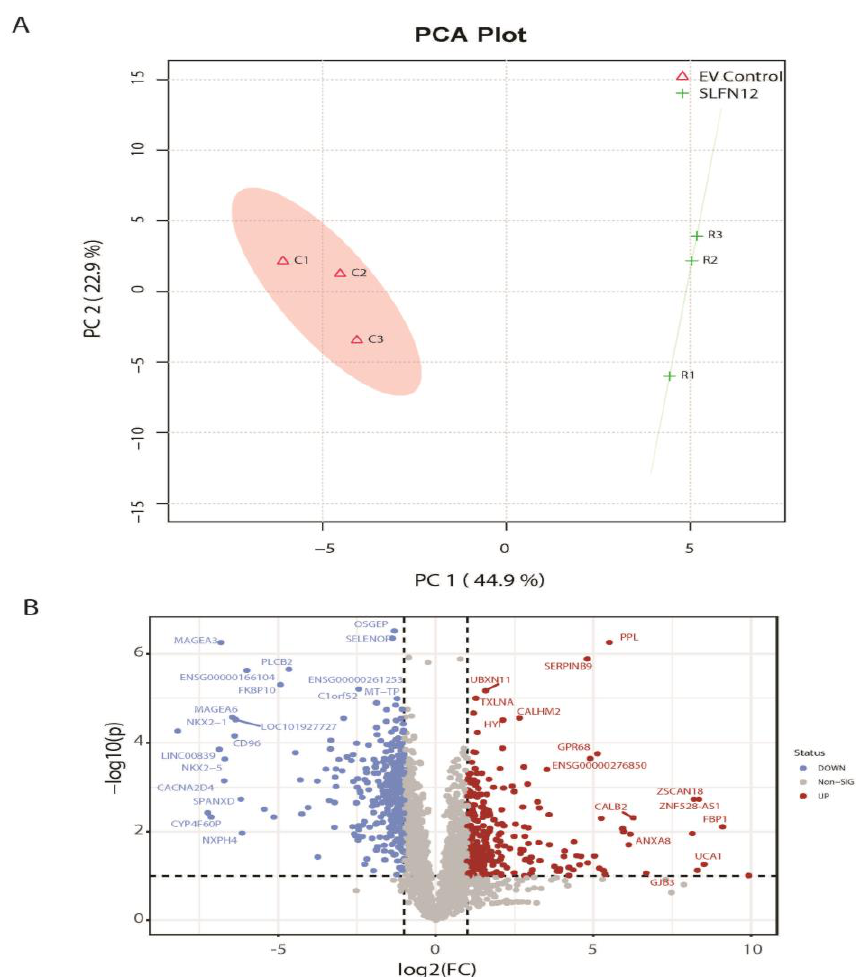
Figure 2. ( A ) Sample distribution of gene expression profiles: principal component analysis (PCA) plot showing clusters of samples based on similarity. The first two PCA components (PC1 and PC2) of the gene expression profile and overall variance between the groups are displayed. Each dot represents a sample color coded by both latency and SLFN12 expression. ( B ) Volcano plot of differentially expressed genes described in Supplementary Table S2.